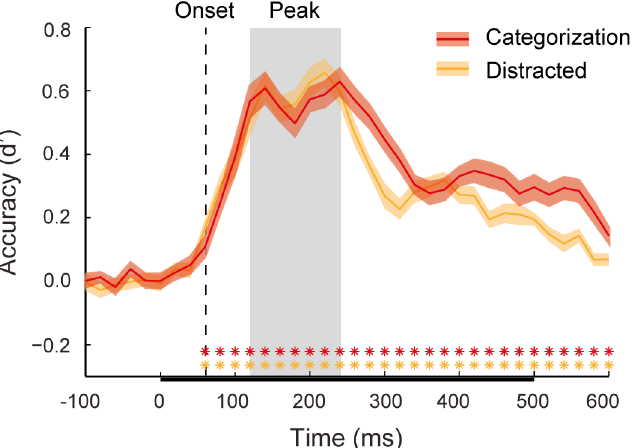
indicate +/- 1 SEM across subjects. Color-coded asterisks indicate time points at which classifier performance was significantly above chance, using a Wilcoxon signed rank test ( * = false discovery rate (FDR) adjusted p < 0.05). Decoding onset for both data sets (60ms) is indicated by a dashed vertical line. The period of peak decoding is indicated by a gray box extending 120 – 240 ms post-stimulus onset. The bar along the x-axis indicates the stimulus